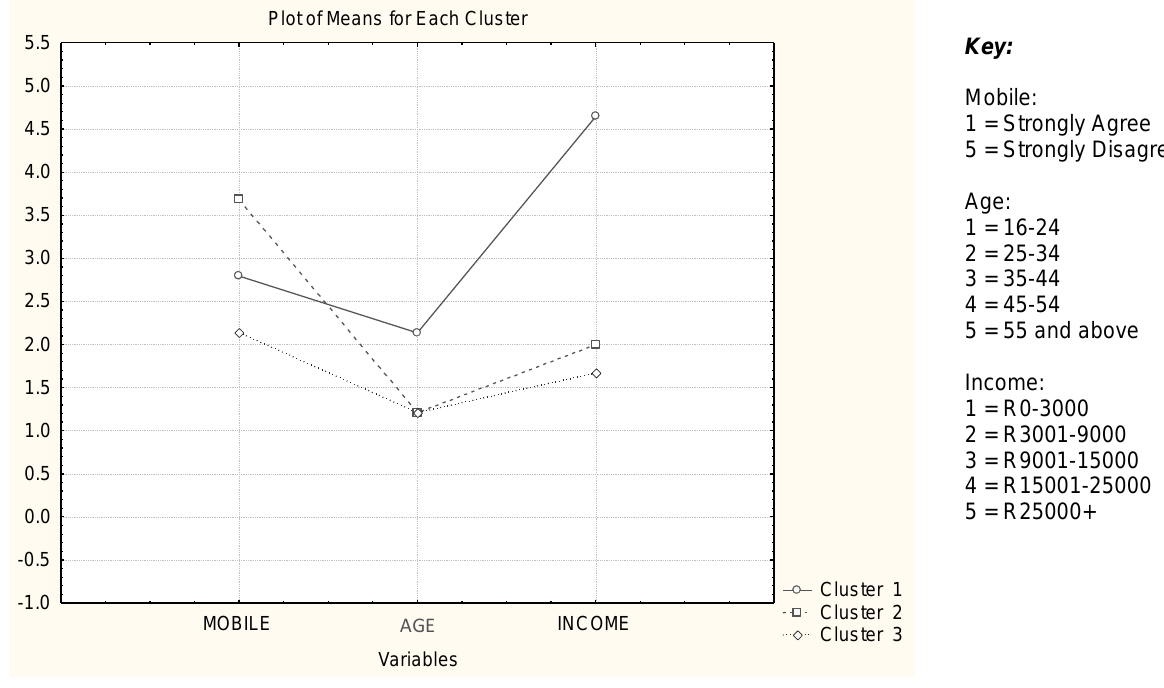
Figure 2: A plot of means comparing the variables mobile, age and income. Plot of Means for Each Cluster